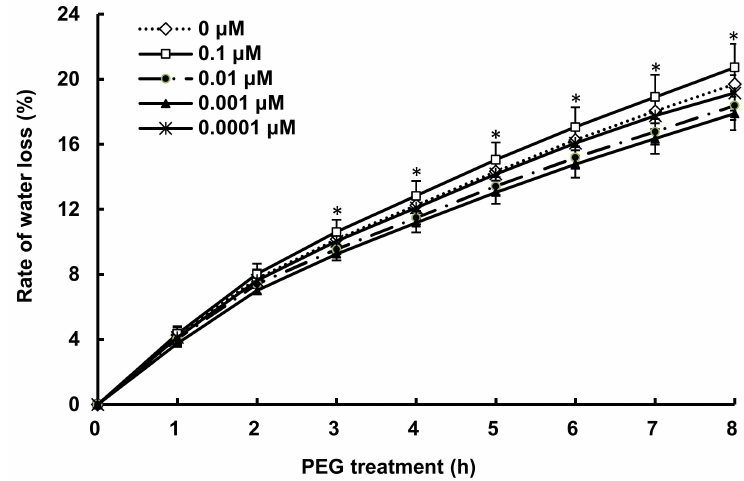
Figure 1. Water loss rates of detached maize plants treated with gradient concentration of COR under PEG treatment. Plants were pre-treated with 0, 0.1, 0.01, 0.001, 0.0001 µ M COR for 12 h, then water loss of isolated detached plants was monitored every 1 h over 8 h with 10% PEG treatment. Values are the mean ± SD ( n = 8) , asterisks indicate significant differences ( p < 0.05) between 0 and 0.001 µ M using Student’s